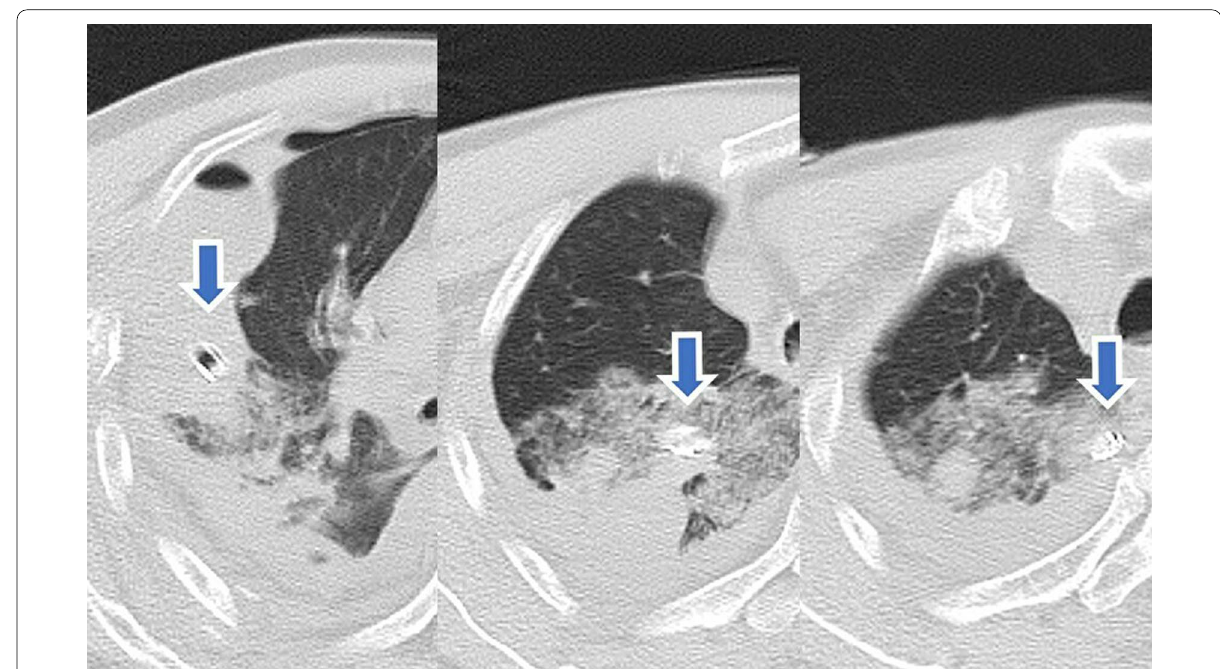
Fig. 1 Computed tomography showing chest tube (arrows) stabbing the right upper